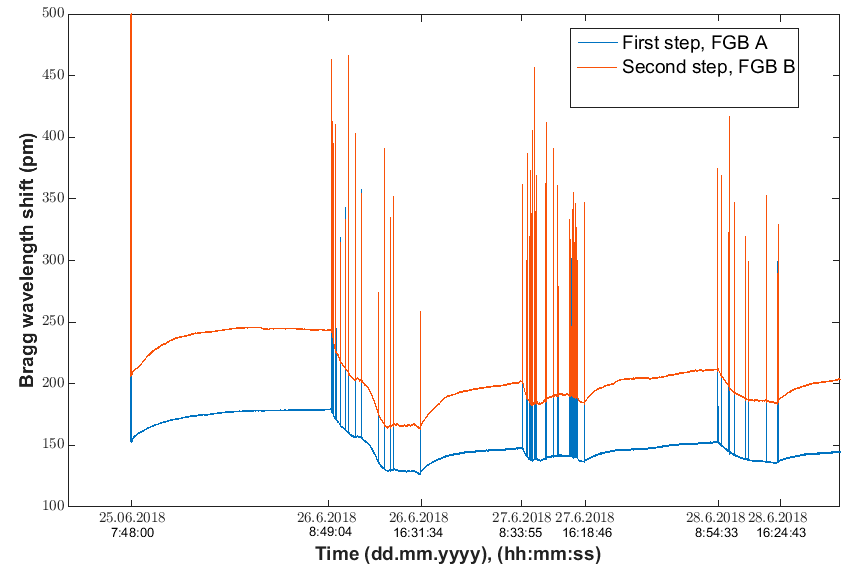
Figure 11. The waveform of signals from FBG A and FBG B sensors during the 24-h measurement of recognition of the number occupants in room R104 in the period from 25 June 2018 (7:48:00), to 28 June 2018 (23:59:00).